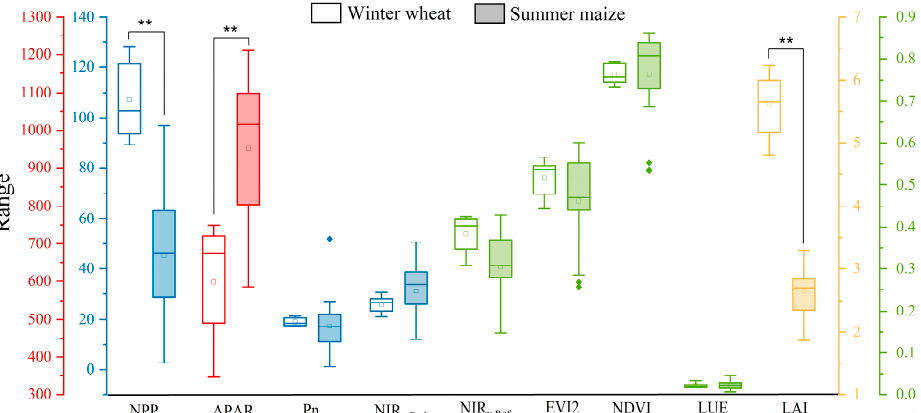
Figure 4. Changes in vegetation and physiological indices on the daily scale, and difference analysis between winter wheat and summer maize. The significance values: p < 0.01. Box plot colors correspond to those of the coordinate axes. Hollow box plots represent winter wheat, while solid box plots represent summer maize. Asterisk denotes statistically significant differences ** p < 0.01.